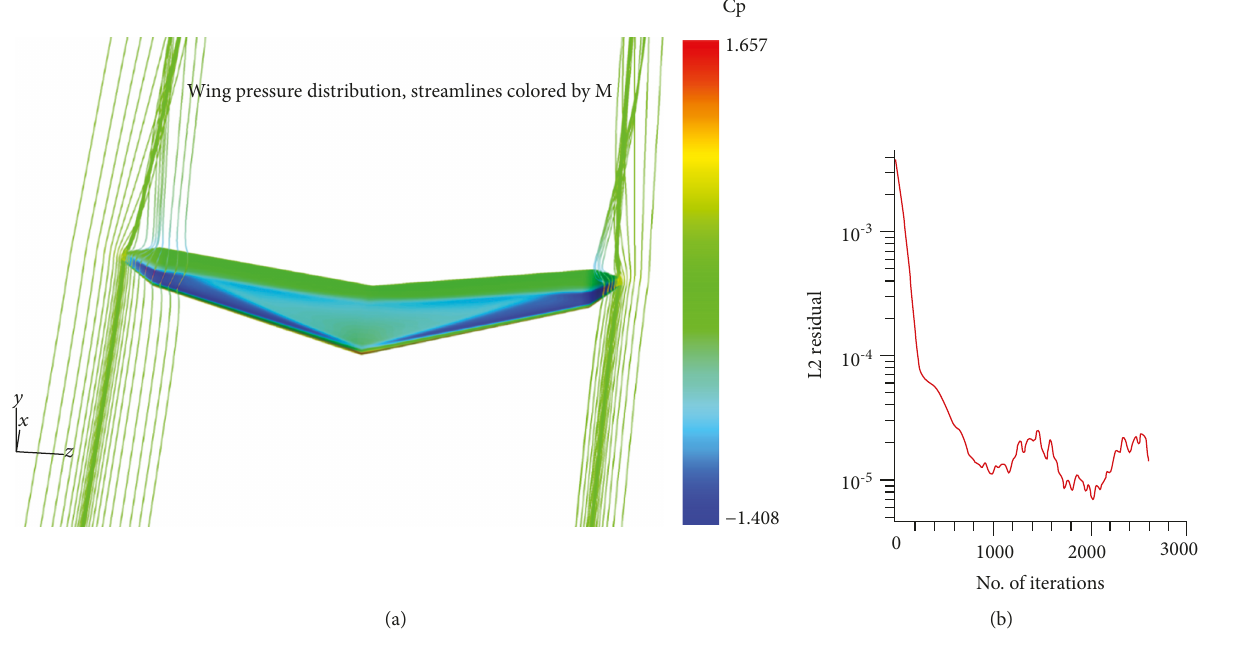
Figure 20: ONERA M6 wing with folding tip under SW1. Table 4: Lift and drag coe ffi cients of the ONERA M6 wing with and without folding